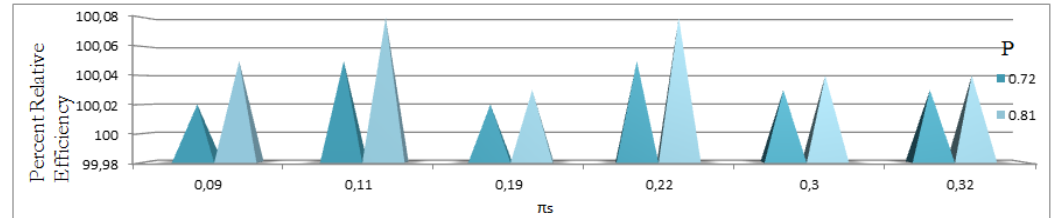
Figure 3 - Percent relative efficiency of the proposed estimator (under optimum allocation) with respect to Manga and Singh (1994) estimator